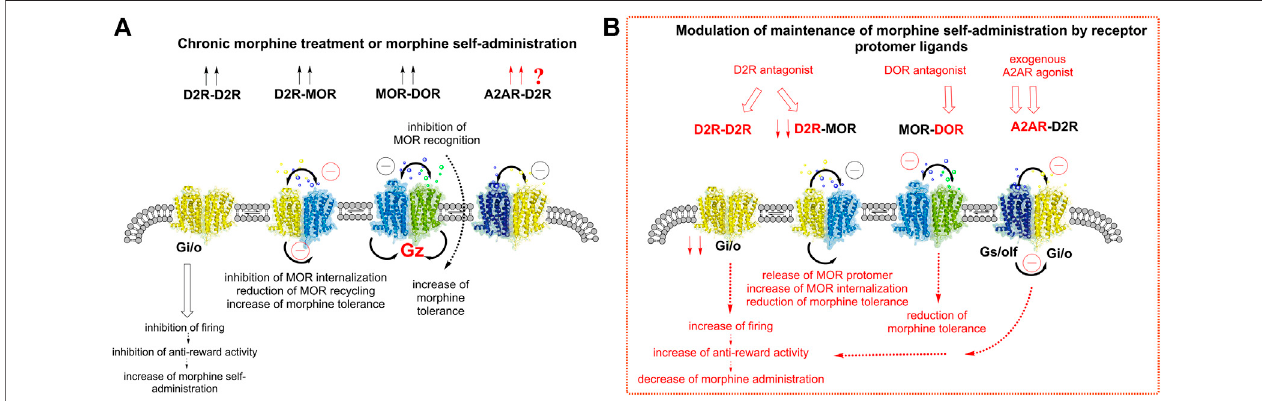
FIGURE 2 | Understanding the role of the A2AR-D2R heteroreceptor complexes in modulating the changes in the activity of the ventral striatal-pallidal GABA antireward neurons induced by chronic morphine treatment or morphine self-administration. (A) Morphine (chronic) is shown to increase the density of D2R-D2R homomers (2 arrows pointing upwards). This causes enhanced inhibition of fi ring in the antireward neurons leading to a reduction of antireward activity. An increase of morphine self-administration is found. The D2R-MOR complex also becomes increased in density after morphine (chronic) mainly due to inhibition MOR internalization. This event will result in a reduction of MOR cycling, which impairs its signaling, and a reduction of recognition also develops due to antagonistic allosteric receptor-receptor interactions. As a result, an increase in morphine tolerance takes place since higher doses of morphine are needed to induce reward due to the malfunctionoftheMOR signaling.Itisalso proposed thatanincreaseddensity ofA2AR-D2Rcomplexes developsuponexposure tochronicmorphine asseenfrom the two red arrows indicated. As a result, the D2R function becomes reduced through an allosteric brake on D2R signaling. The MOR-DOR complex is well known to be increasedindensityuponchronicmorphinetreatmentormorphineself-administration,shownby2arrows.BothreceptorprotomersremainfunctionalbycouplingtoGz protein. However, the morphine activation of the DOR protomer is known to produce a brake on MOR recognition via an allosteric receptor-receptor interaction. Therefore, an increase in morphine tolerance takes place. (B) Modulation of morphine effects by receptor protomer ligands. The D2R antagonist is known to block the inhibitory D2R homomer signaling over Gi/o and produces a marked reduction of morphine self-administration. In the case of the D2R-MOR complex, the D2R antagonist appears to disrupt the complex and set the MOR protomer free from D2R mediated allosteric inhibition. MOR internalization is therefore increased and its function restored, leading to a reduction of morphine tolerance due to enhanced MOR signaling induced by morphine. It is indicated that the A2AR agonist given in vivo should effectively inhibit the function of the D2R protomer of the A2AR-D2R complex, increased in density (see A ). Thus, a reduction of the inhibitory Gi/o activity of the D2R protomer develops which results in an increase in the activity of the anti-reward GABA neurons. A reduction of morphine self-administration should develop. The DOR antagonist can target the DOR protomer and remove its allosteric inhibition of the MOR signaling, which reduces morphine